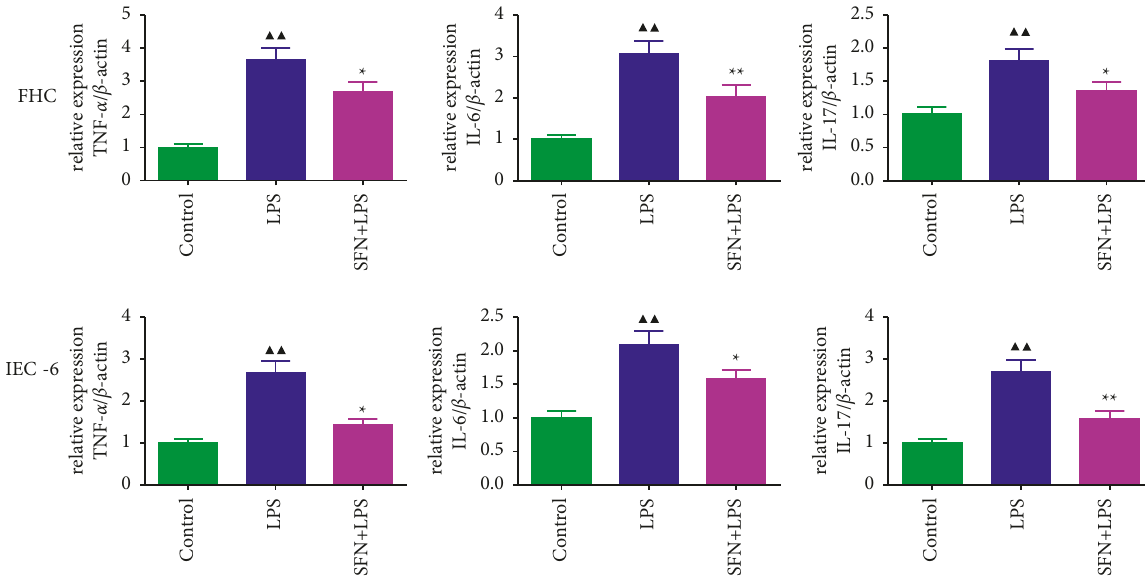
Figure 6: The mRNA expression of TNF- α , IL-6, and IL-17 in FHC and IEC-6 cells. LPS, lipopolysaccharide; SFN, sulforaphane. Compared with the control group, ▲ P < 0 . 05, ▲▲ P < 0 . 01; compared with the NEC group, ★ P < 0 . 05, ★★ P < 0 . 01. Data represent the mean ± SD, n � 3.